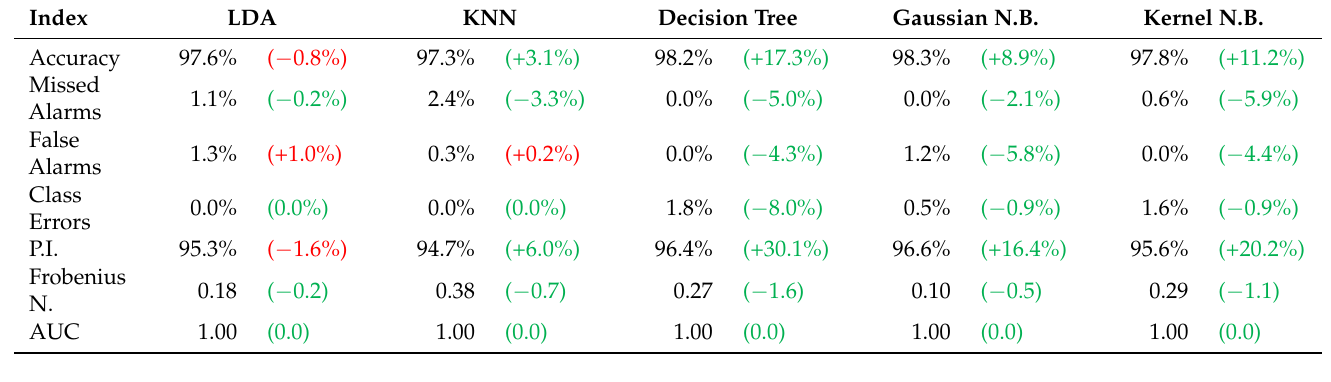
Table 4. Performance indices obtained applying the proposed CRM entirely (CCA+MNI). SMOTE and Tomek Links methods were considered in the analysis for the data balancing. The variations with respect to the solely CCA pre-processing (in Table 3) are shown in brackets. Please note that the percentage variations highlighted in green represent an improvement (increase in precision and decrease in errors), while those in red indicate a worsening in terms of performances.